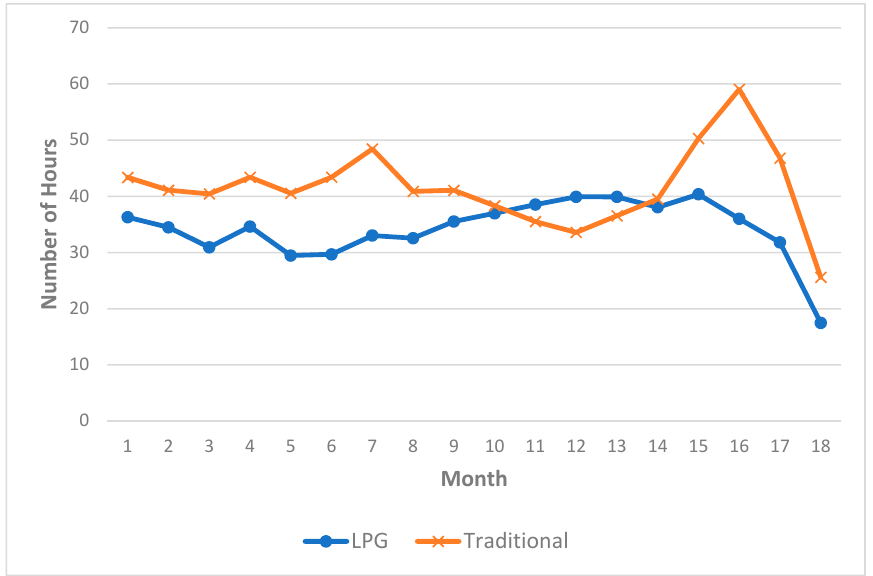
Figure 2. Average number of hours of LPG and Traditional Stove use per month for all study households over 18 months of monitoring.